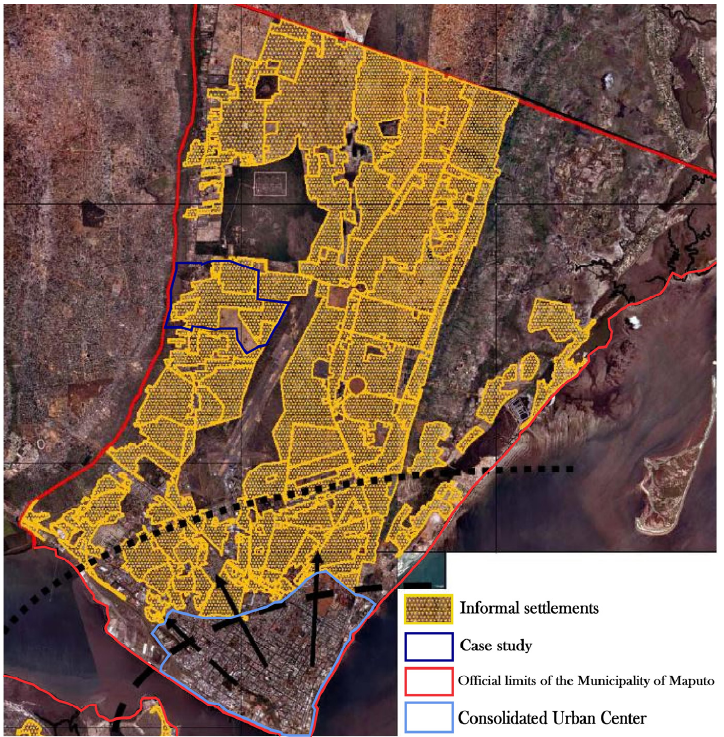
Figure 3. Location of informal settlements in Maputo City (source: [99], edited by the authors). Characterisation of Informal Settlements